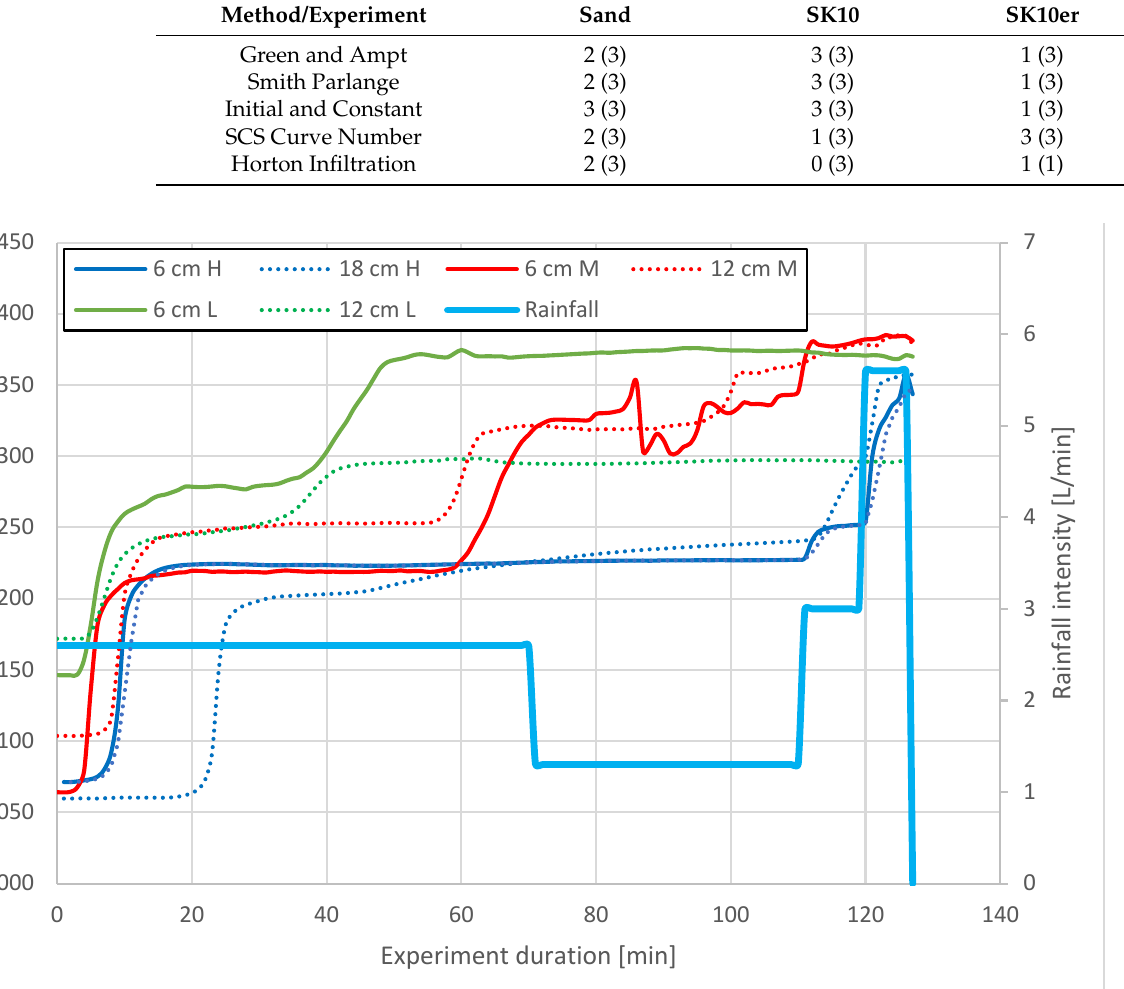
Figure 4. A photo of the Sand experiment around 90 min after the start of the rainfall simulation ( left ), showing the evolution of the retrogressive sliding following the formation of the rotational